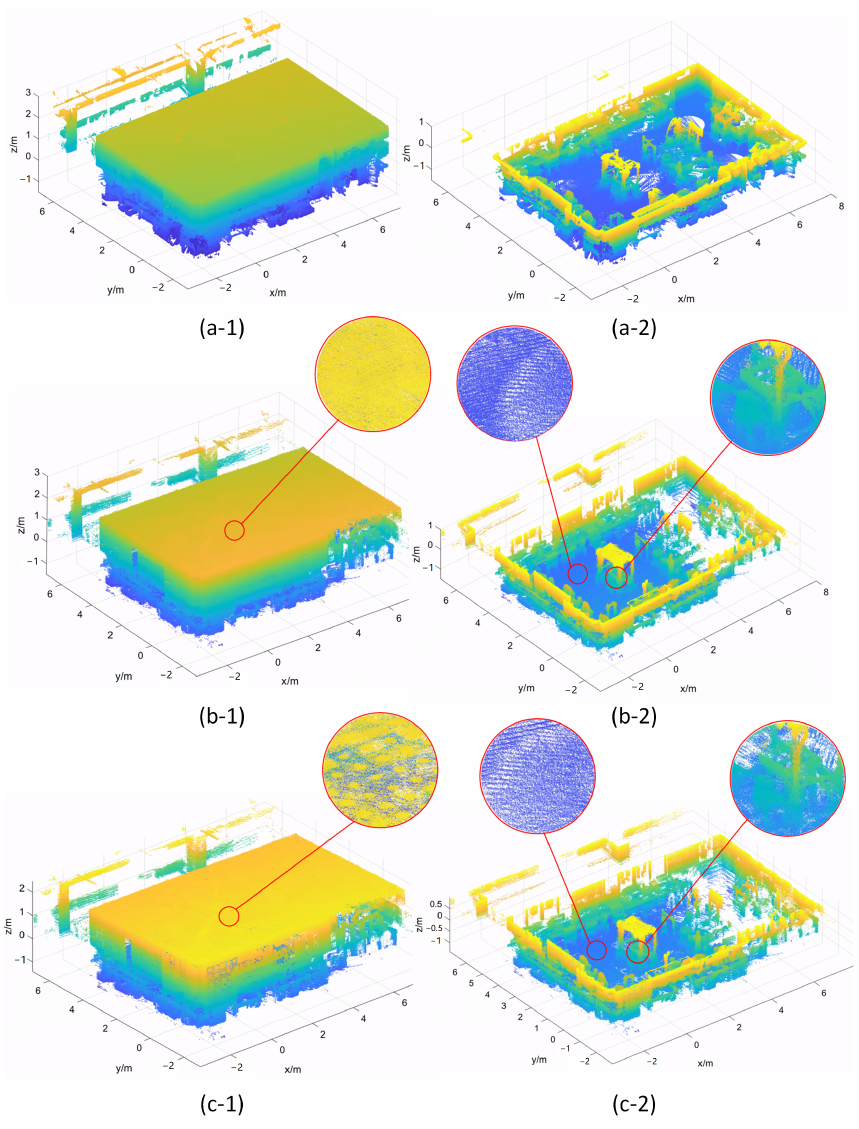
Figure 4. The result of the room environment mapping experiment (colored by depth). ( a-1 , a-2 ) show the ground truth. ( b-1 , b-2 ) show the mapping result without variable resolution strategy. ( c-1 , c-2 ) show the mapping result with variable resolution strategy. The full maps are on the left, and the interior details are on the